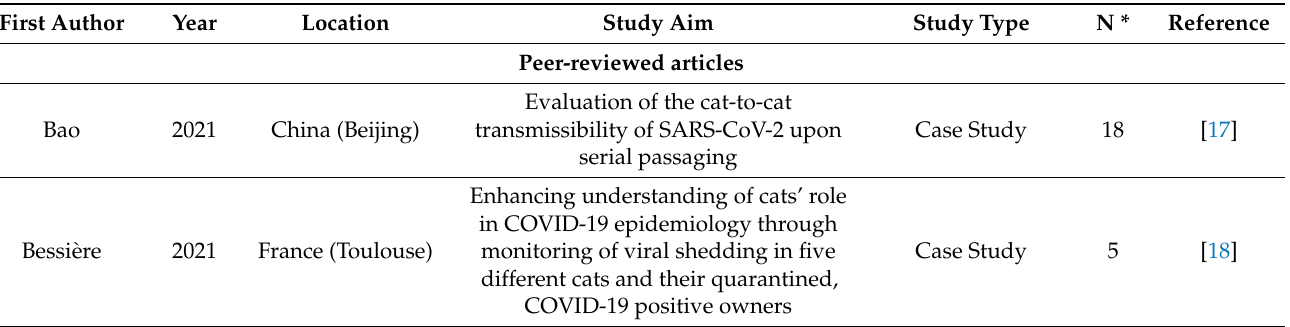
Table 2. Overview of eligible records and their